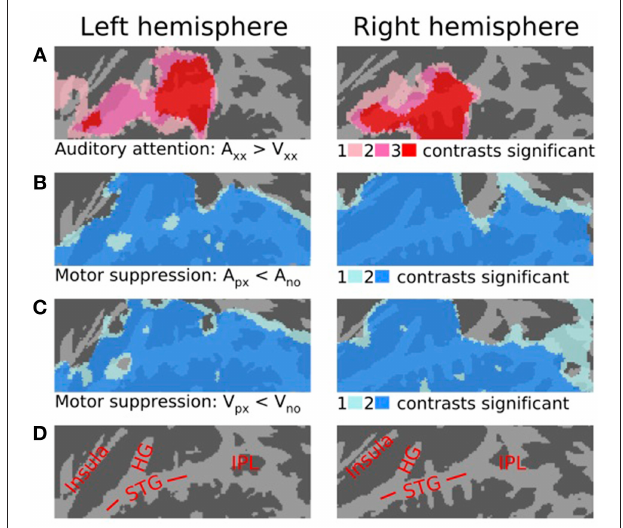
FIGURE 1 | The effects of auditory attention and motor responding on activations to sounds shown on a flattened mean 2D cortical surface ( N = 16 , corrected P < 0.05 ). (A) The areas where activations were enhanced during the auditory task as compared with visual task with identical stimuli and motor responses. The results of three separate contrasts (A pr > V pr , A po > V po , A no > V no ) are plotted so that areas where any one of the contrasts was significant are shown in pink and areas where all three contrasts were significant are shown in red. (B) Motor suppression during the auditory tasks. The results of two contrasts (A pr < A no , A po < A no ) are plotted so that areas where either of the contrasts was significant are shown in light blue and areas where both contrasts were significant are shown in darker blue. (C) Motor suppression during the visual task (V pr < V no , V po < V no ). (D) Anatomical labels: STG, superior temporal gyrus; HG, Heschl’s gyrus; PT, planum temporale; IPL, inferior parietal lobule.